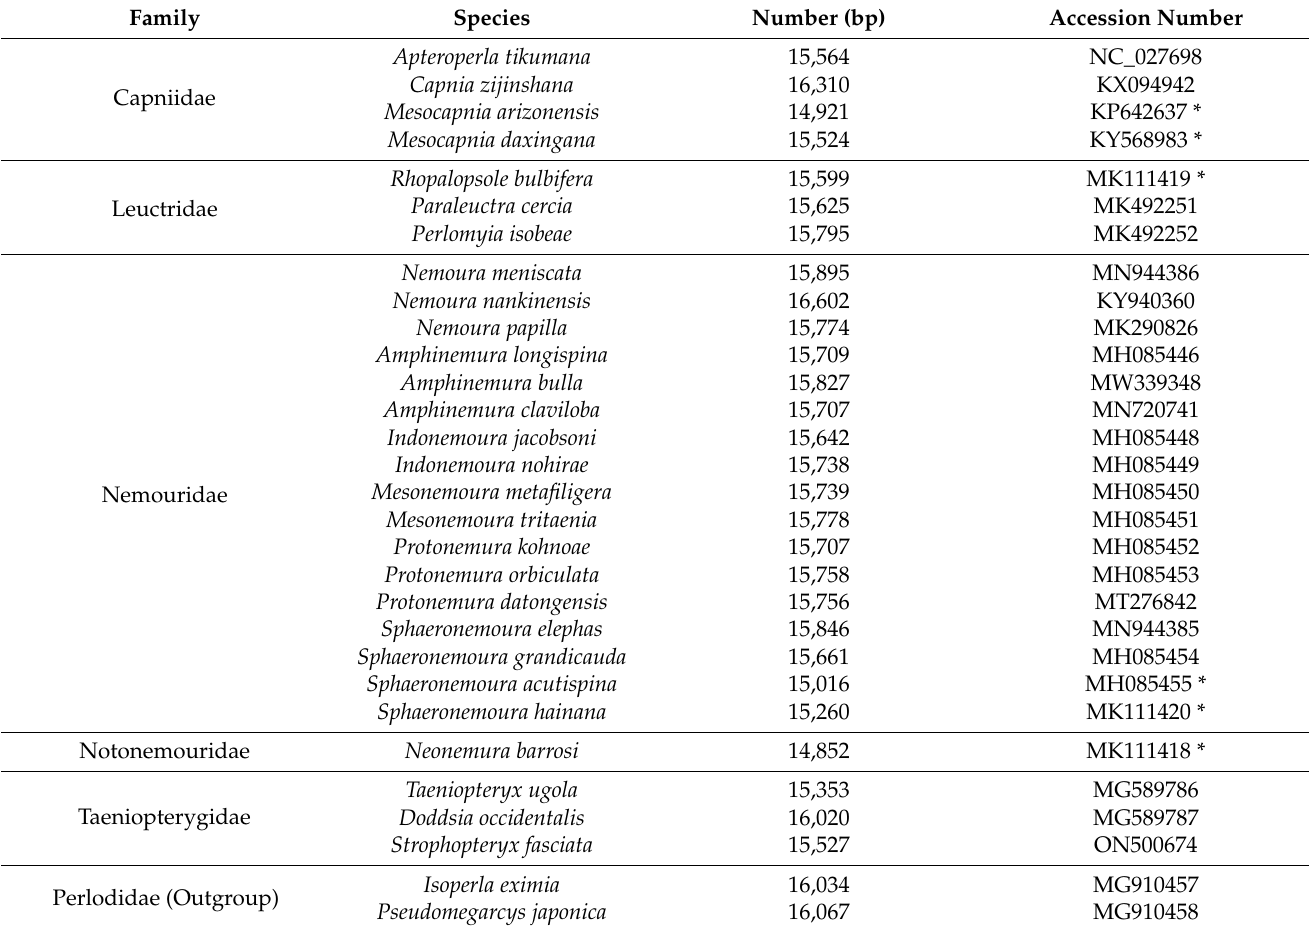
Table 1. General information of nemourid species used in this